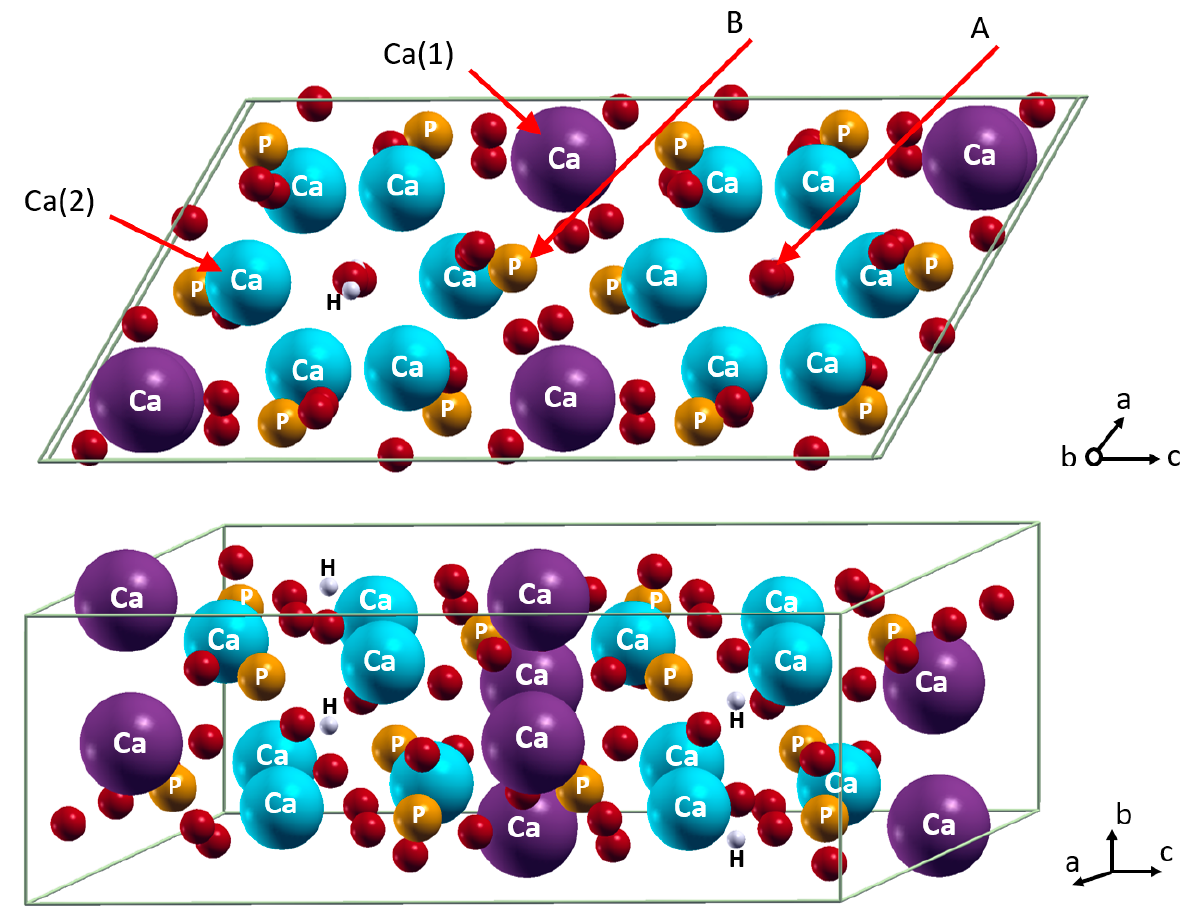
Figure 1. Incorporation of foreign cations in Ca(1) and Ca(2) positions and anions in A and B positions. Color coding: Ca in Ca(1) position–magenta; Ca in Ca(2) position–cyan; P–orange; O–red; H–white. For clarity, all atoms except oxygen are named.